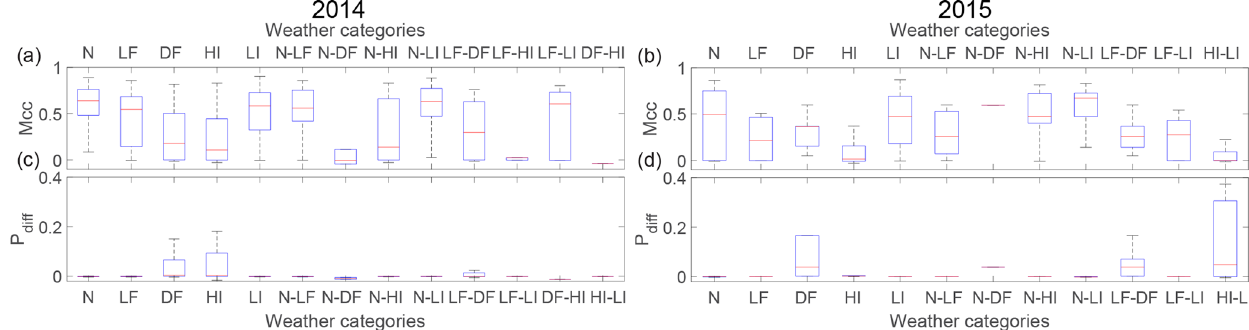
Figure 7. Box plot of Matthews correlation coefficient, Mcc, when Mcc (cid:54)= 0 and Mcc (cid:54)= 1 for (a) 2014 and (b) 2015. Positive difference percentage, P diff , when Mcc = 0 (no matched pixel) for normal conditions (N), light fog (LF), dense fog (DF), high illumination (HI), low illumination (LI) and a combination of each for (c) 2014 and (d) 2015.